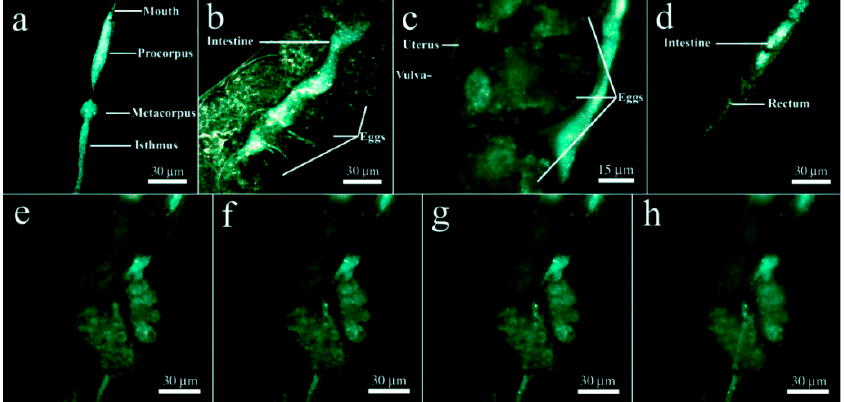
Figure 7. HNT localization in the nematode’s intestines by EDF microscopy: ( a ) inside the foregut; ( b , c ) in the midgut; ( d ) inside the hindgut; ( e – h ) EDF images of the intestine near the uterus taken at different focal planes demonstrating the localisation of HNTs exclusively inside the intestine.